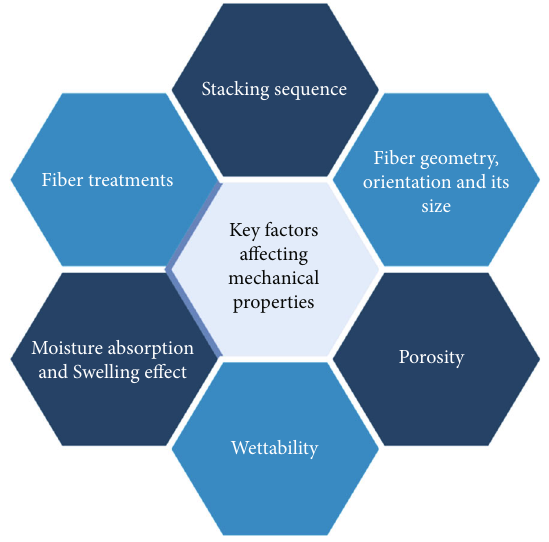
Figure 4: Key factors a ff ecting mechanical properties of